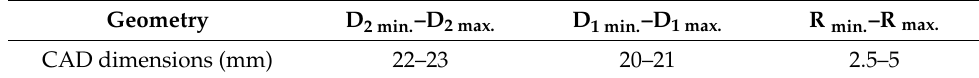
Figure 1. Railway fasteners: ( a ) components of the head and ( b ) main geometric variables. The influence of the hub wall angle and the hub to cap radius was analyzed. The hub wall angle comes from the dimensions of the base D2 and the top face D1. Table 1 shows the minimum and maximum values corresponding to both variables, D1 and D2 and the hub to cap radius R. Table 1. CAD dimensions of the head of the spike screw.